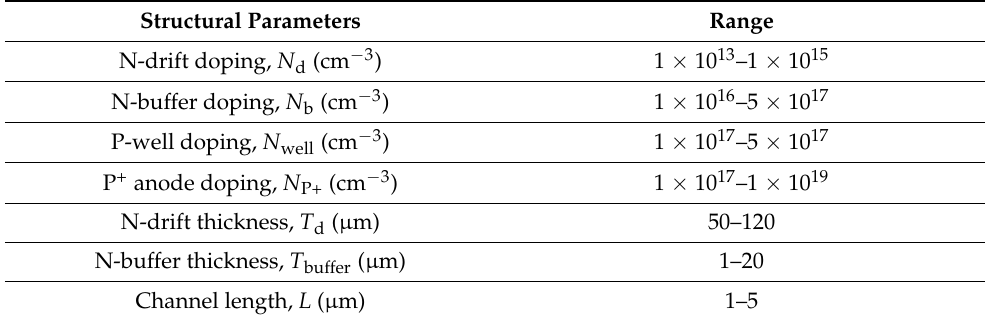
Table 1. Structural parameters and ranges of the IGBT. Structural Parameters